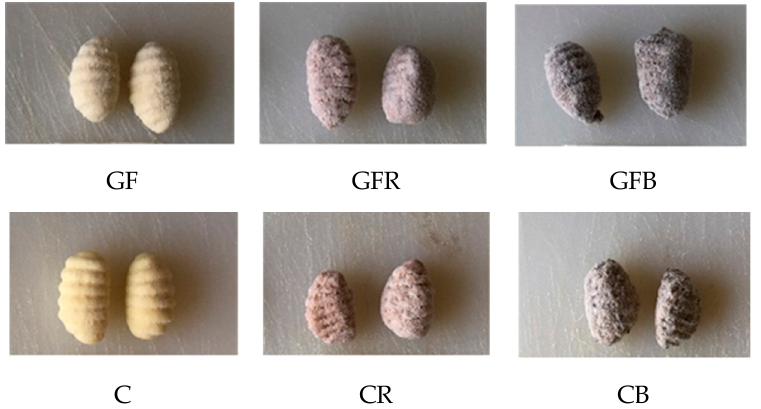
Figure 1. Gluten free (GF) and conventional (C) potato-based pasta samples without or with 20% addition of red rice (R) or buckwheat (B) flour.